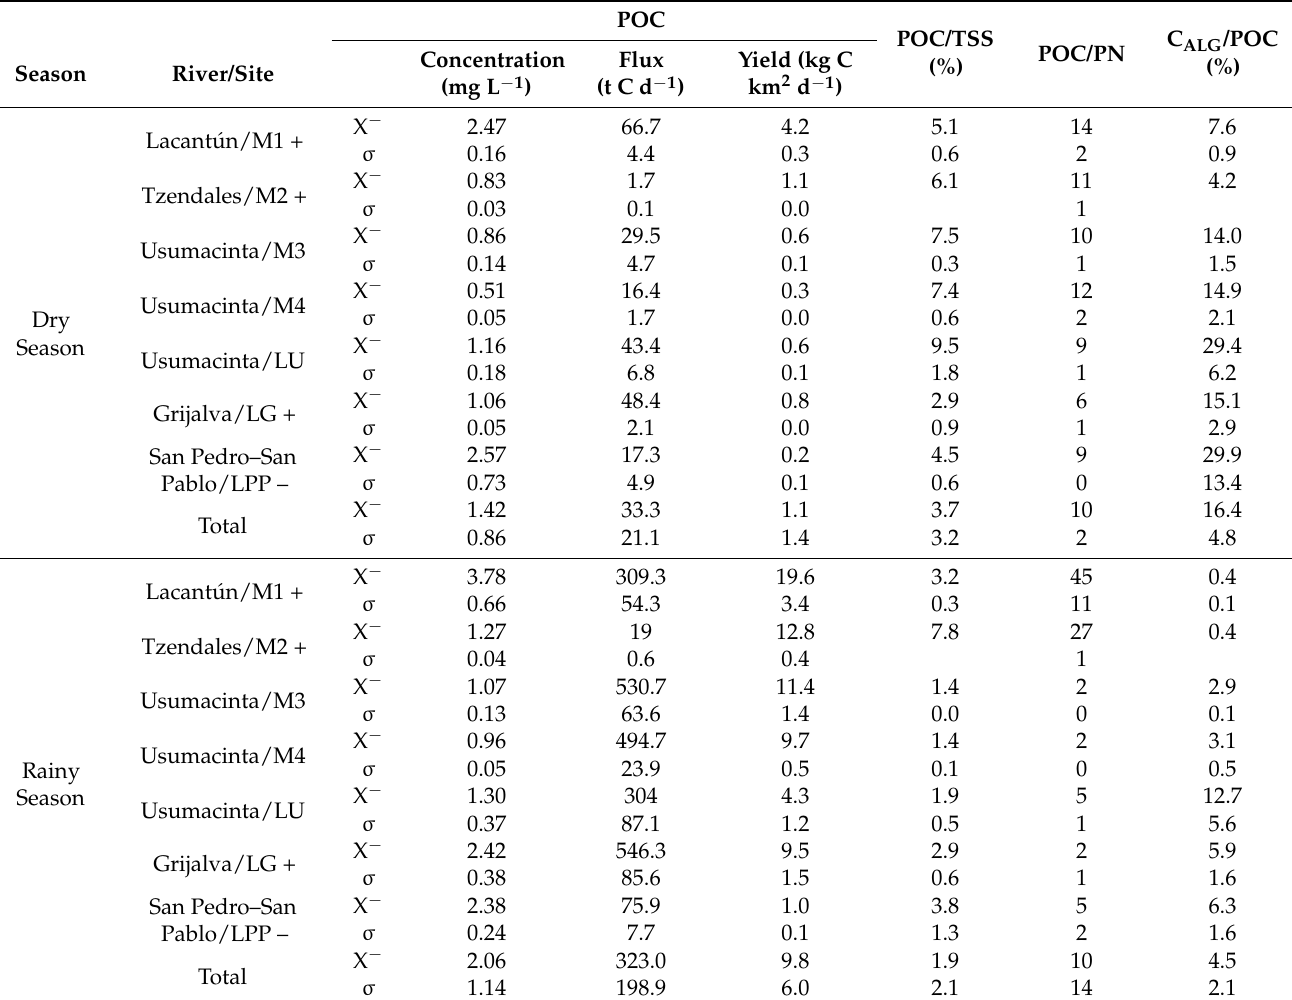
Table 2. Average (first line) and standard deviation (second line) values of POC concentration, POC flux, POC/TSS, POC/PN, and C ALG /POC ratios in the sampling sites of the Usumacinta River in the dry and rainy seasons.